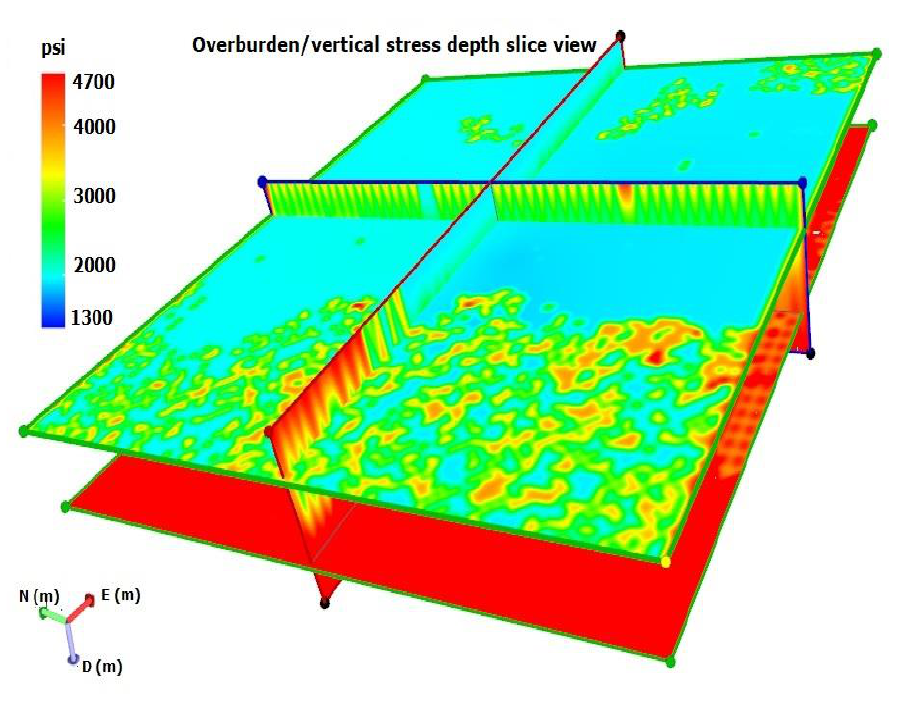
Figure 10. 3D depth slice view of overburden pressure (Sv) distribution at is 430m and 1636m.